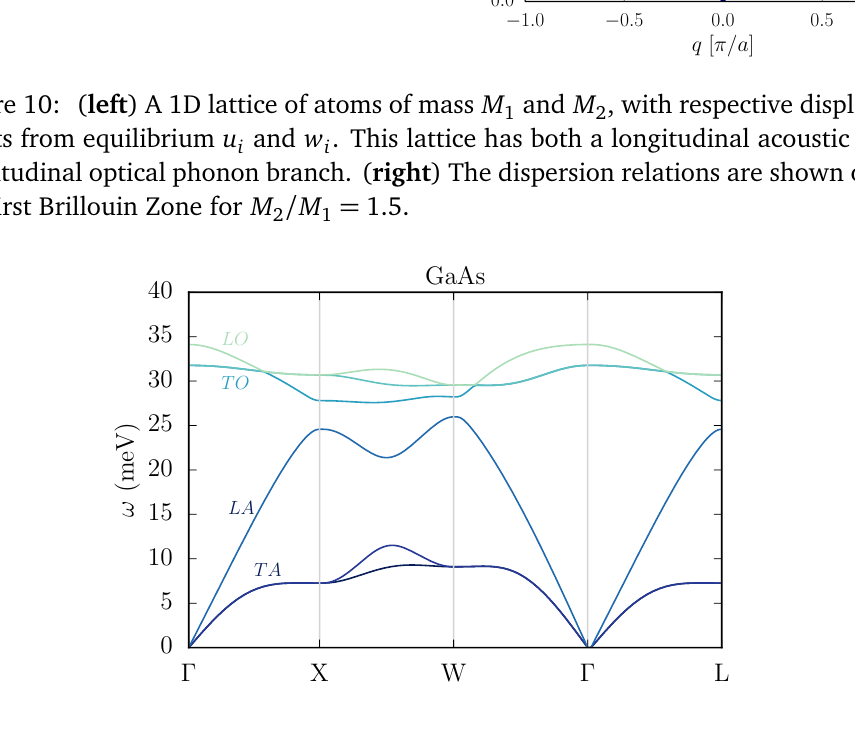
Figure 11: A representative phonon band structure. The Γ point is where q = 0, and the acoustic modes are indicated by TA (transverse acoustic) and LA (longitudinal acoustic). The TO and LO branches are the optical phonon modes. Reproduced from Ref. [ 64 ]